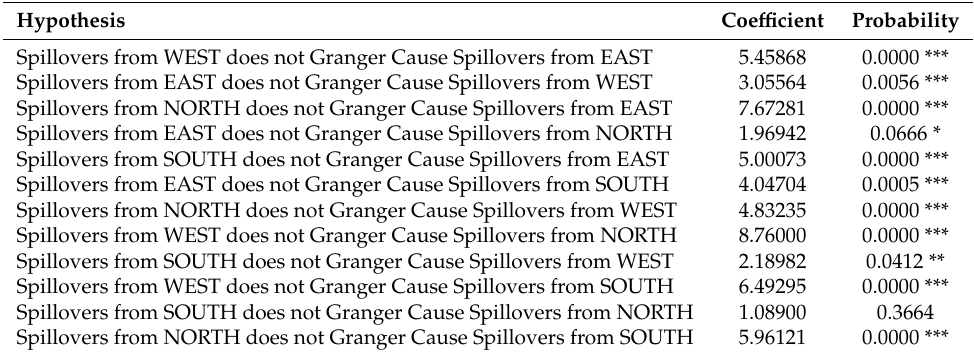
Table 2. Granger causality test for the geographical position